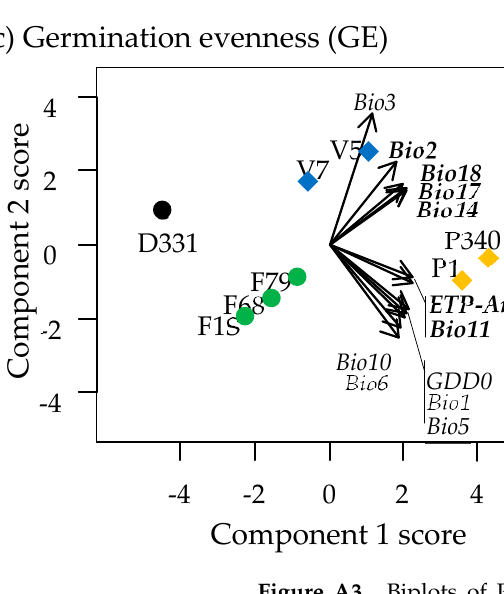
Figure A3. Biplots of PLSR for three germination variables showing the association between genotypes (normal font) and climatic variables graphically (in italics). Genotypes of P. urvillei were not included in this PLSR optimization: ( a ) First principal component (PC1) scores from PCA, ( b ) germination ability (GA), and ( c ) germination evenness (GE). Colors identify the species: black = P. dasypleurum (D331), green = P. flavescens (F1S, F68, F79), blue = P. vacarianum (V5, V7), and orange = P. plurinerve (P1, P340). Southernmost distributed species are represented with circles and northernmost species with diamonds. Predictor (climatic) variables in a bold letter had importance in projections higher than one (VIP > 1). The references of climatic variables are in Table A1. Table A6. Linear regression adjustment ( R 2 ) between each germination variable (PC1, GA and GE) as response and environmental variables with importance in projection higher than one (VIP > 1) after optimizing PLSR as predictors. Results when P. urvillei genotypes are included (left) and when P. urvillei genotypes are not included (right) are shown. High adjustments ( R 2 ≥ 0.80) were high- lighted with bold letters.